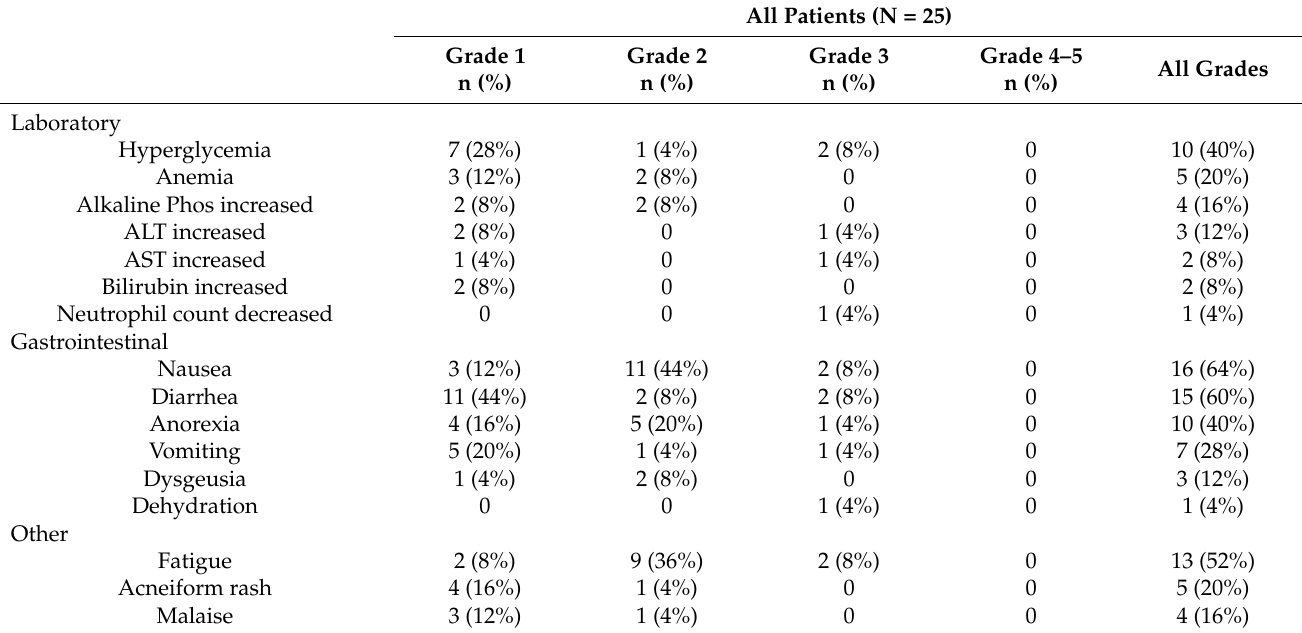
Table 3. Adverse events (all grades, occurring in 5% of patients) suspected to be related to study treatment. All Patients (N =